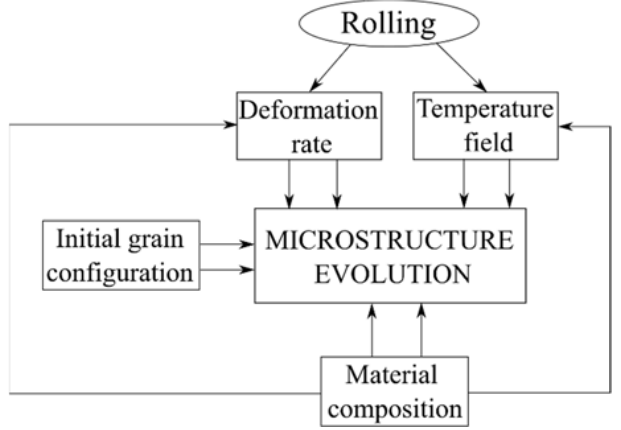
Figure 2. Picture of one-way macro-micro coupling.